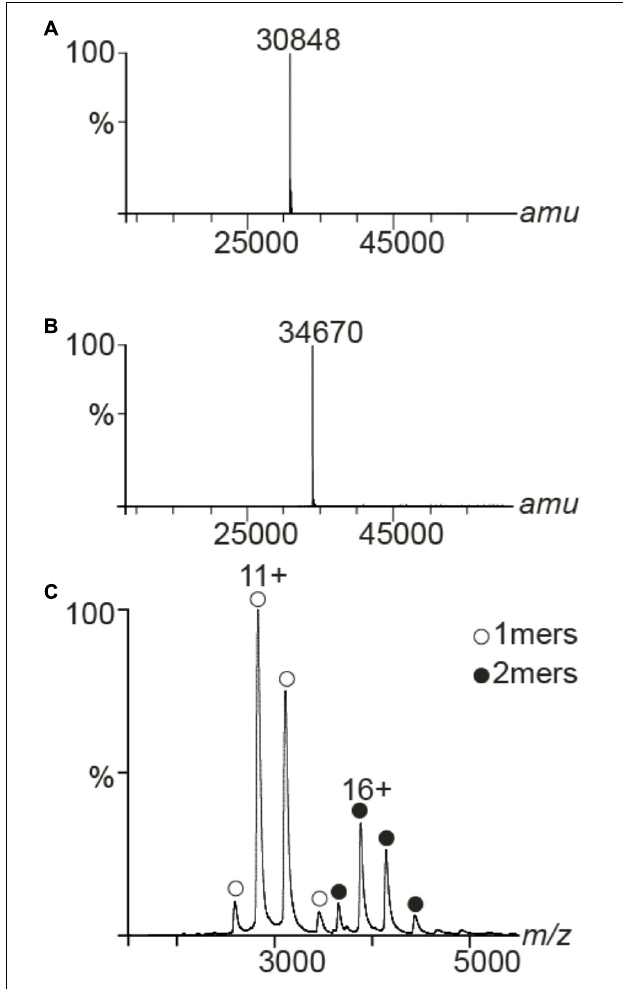
FIGURE 4 | MS spectra of PAP9. Deconvoluted spectra of PAP9-6His (A) and 15 N, 13 C-6His-PAP9 (B) . Under denaturing conditions the accurate mass of PAP9-6His was 30,848 and 34,670 Da for 15 N, 13 C-6His-PAP9. (C) Native MS spectrum of the PAP9-6His. It formed two distinct oligomers, such as monomers (1mer, 30,848 ± 1 Da) and dimers (2mers, 61,697 ± 2